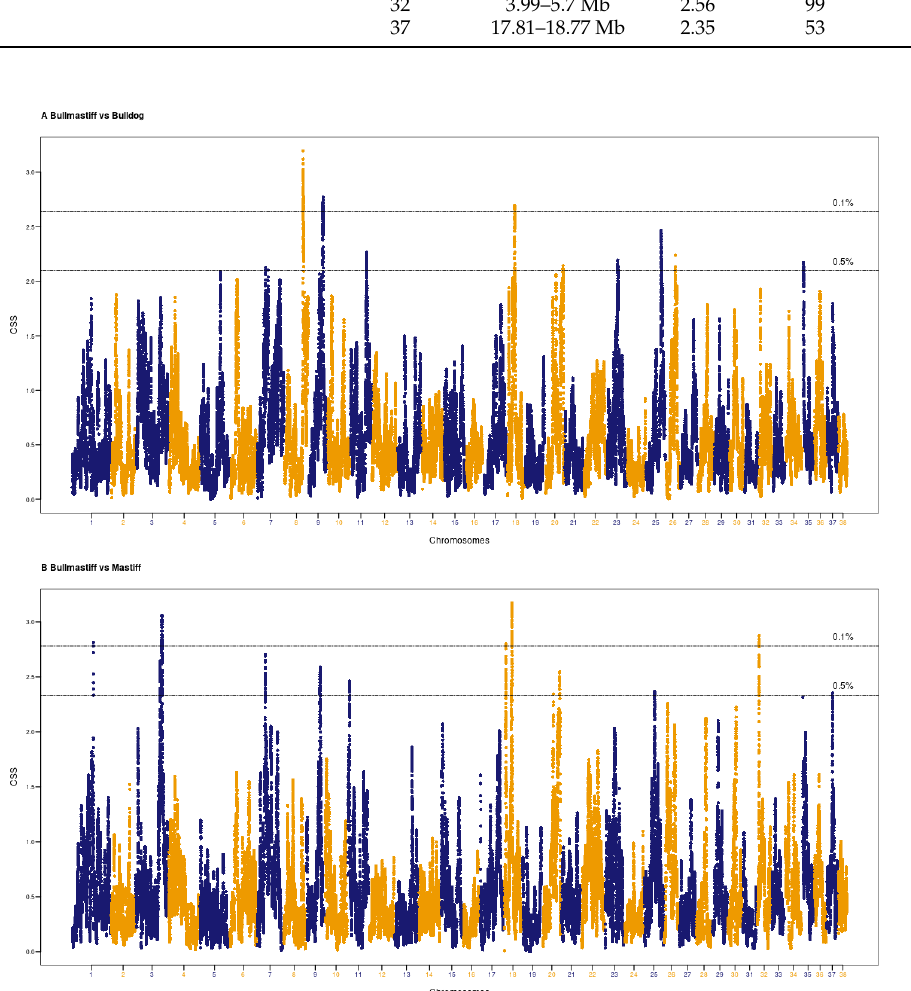
Figure 1. Genomic signals in Bullmastiff dogs detected using the CSS method. The CSS results of the Bullmastiff vs. Bulldog pairwise comparison is shown in the upper Manhattan plot ( A ), and the results of the Bullmastiff vs. Mastiff pairwise comparison is shown in the lower Manhattan plot ( B ). The x-axis represents the 38 autosomes shown in alternate orange and blue color, and the y-axis represents the mean value of CSS scores (F st , ∆ DAF and XP-EHH) in a 1 Mb window size. The horizontal lines are the thresholds for 0.1% and 0.5% CSS value,